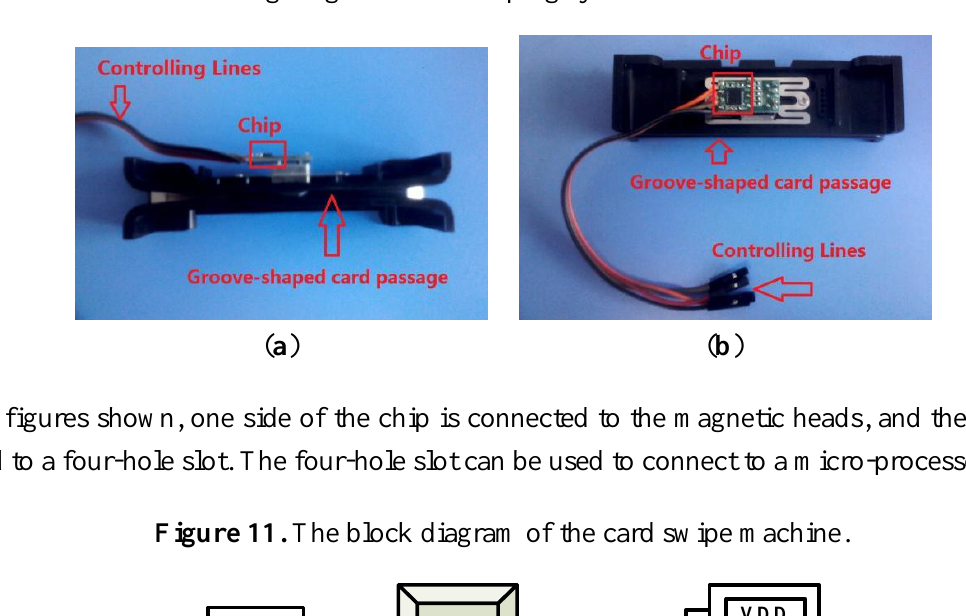
Figure 10. ( a ) Top view of the line-controlling magnetic card swiping system. ( b ) Side view of the line-controlling magnetic card swiping system.